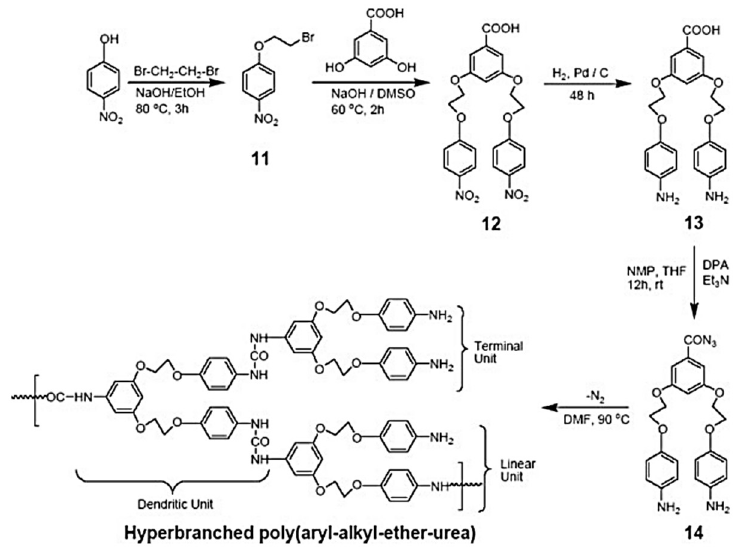
Figure 10. Synthesis of AB 2 -type azide monomer corresponding hyper-branched poly(aryl-alkyl-ether-urea). From reference [41].